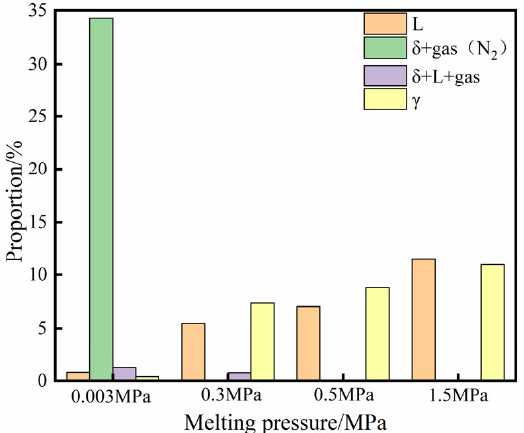
Figure 7. Proportion of each phase zone under di ff erent melting pressure.